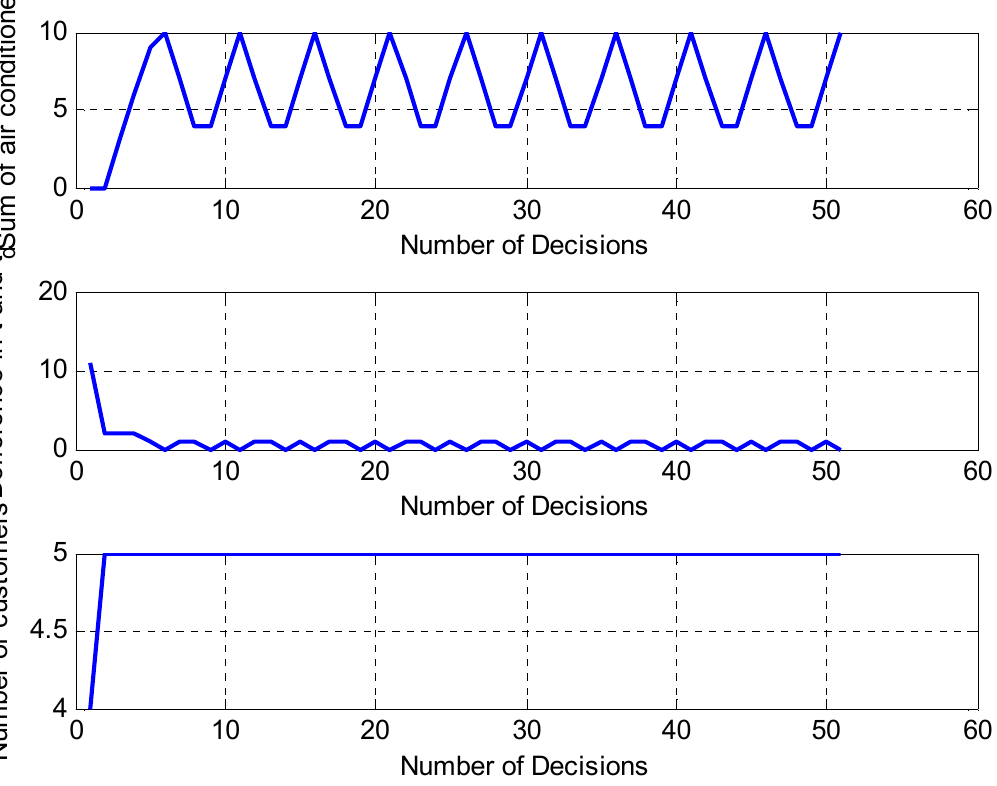
Figure 6. No change in parameters.